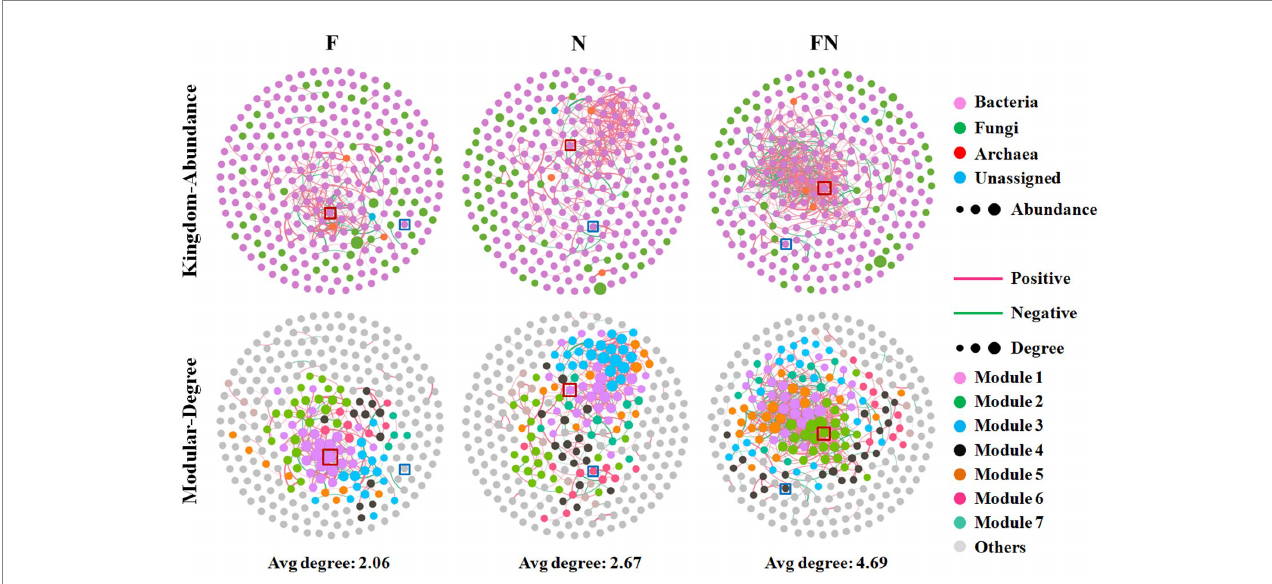
FIGURE 4 Microbial networks among different microbial inoculants. CK, non-inoculated; F, inoculated with B. velezensis FH-1; N, inoculated with B. diminuta NYM-3; FN, inoculated with B. velezensis FH-1 and B. diminuta NYM-3. Bacillus (n37) is labeled by red square, Brevundimonas (n39) is labeled by blue square.